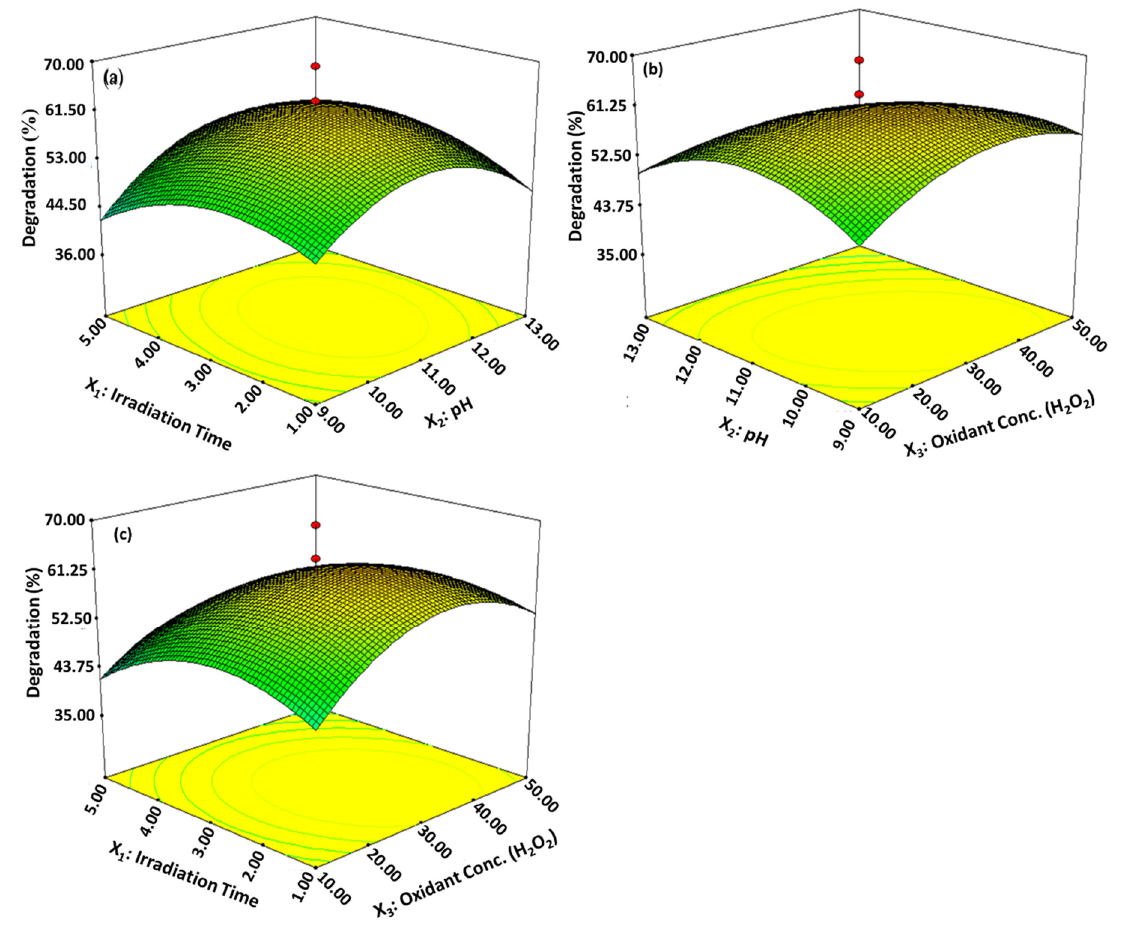
Figure 9. 3D response surface plots. ( a ) Irradiation time and pH, ( b ) pH and concentration of oxidant, ( c ) Irradiation time and concentration of the oxidant, respectively, showing the interactive effect of the independent variable of % degradation of imidacloprid treated with basic prewetted pH on nanocalcite @ PF.